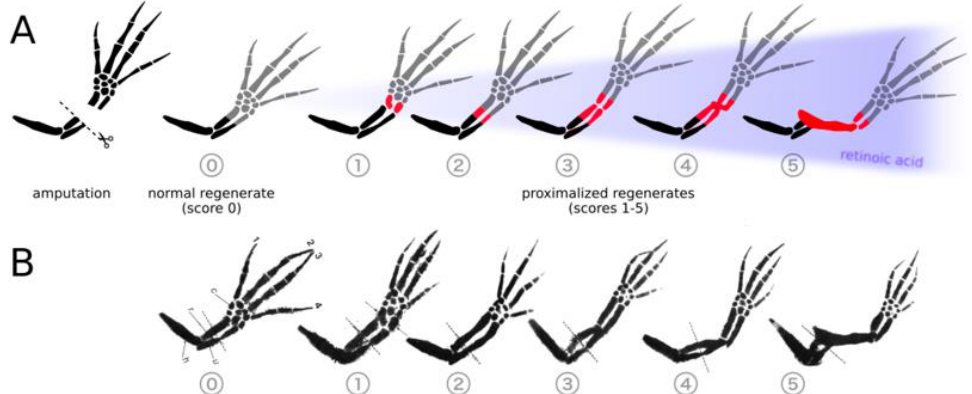
Figure 1. Retinoic acid induces the proximalization of regenerating tissue and duplicates limb elements along the PD axis. ( A ) Following amputation of the axolotl forelimb at the mid-radius/ulna, the regenerate (gray) is identical to the tissue lost. If the regenerating limb is treated with retinoic acid, more tissue is regenerated and limb elements are duplicated (red). Regenerates 1 through 5 depict five possibilities, each showing higher levels of duplication caused by increasing concentrations of RA (blue gradient, increasing from left to right). Regenerate 5 shows complete duplication of the humerus, a result indicative of proximalization to the shoulder level; ( B ) Images of reference limb regenerates scored from normal (score 0) to complete limb duplication (score 5), reproduced from [5].